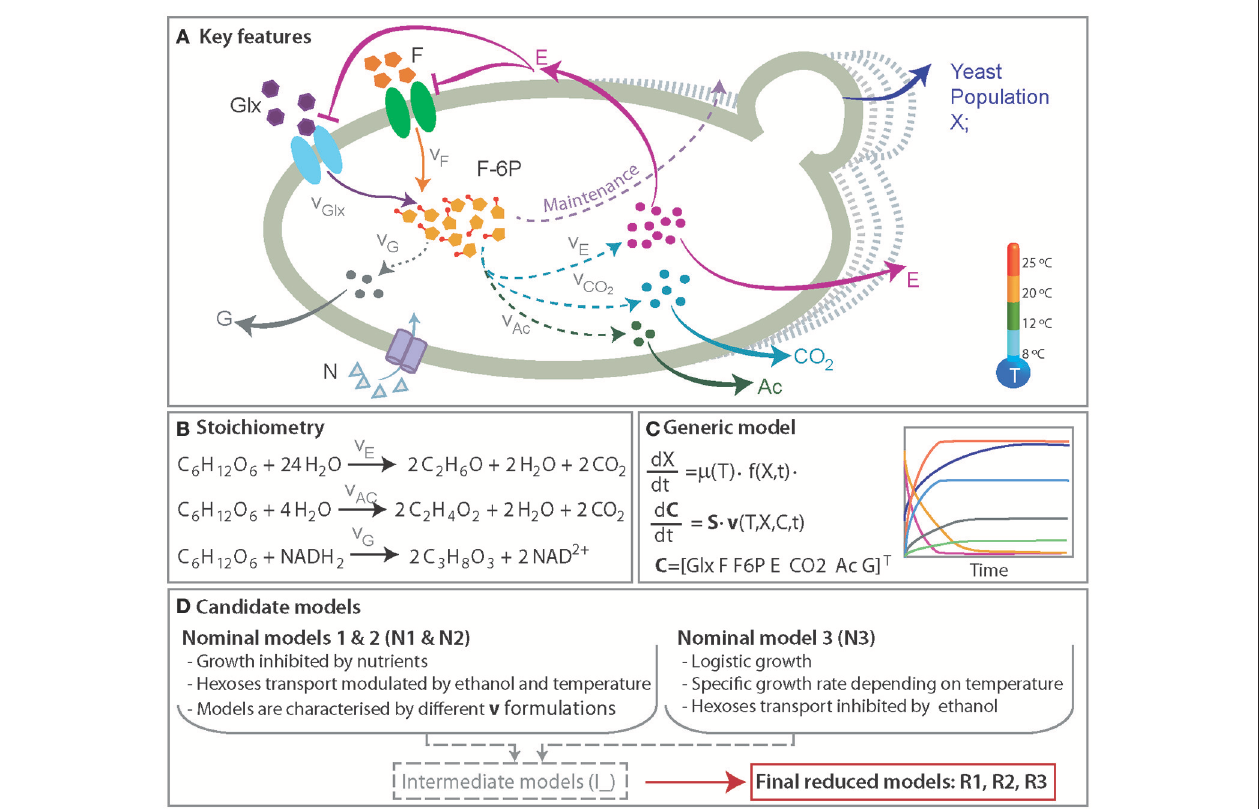
FIGURE 1 | A simplified representation of the anaerobic metabolism of glucose and fructose. (A) Presents the key features of the process including yeast population growth and the production of ethanol (E), glycerol (G), acetic acid (Ac), and CO 2 . The roles of the temperature and ethanol production in the hexoses transport (glucose, Glx and fructose, F) and growth are also incorporated. (B) Presents the set of reactions. (C) Shows an overview of the mathematical model consisting of a set of ordinary differential equations describing the dynamics of yeast population and the relevant metabolites concentrations. (D) summarizes the major mechanisms included in the candidate